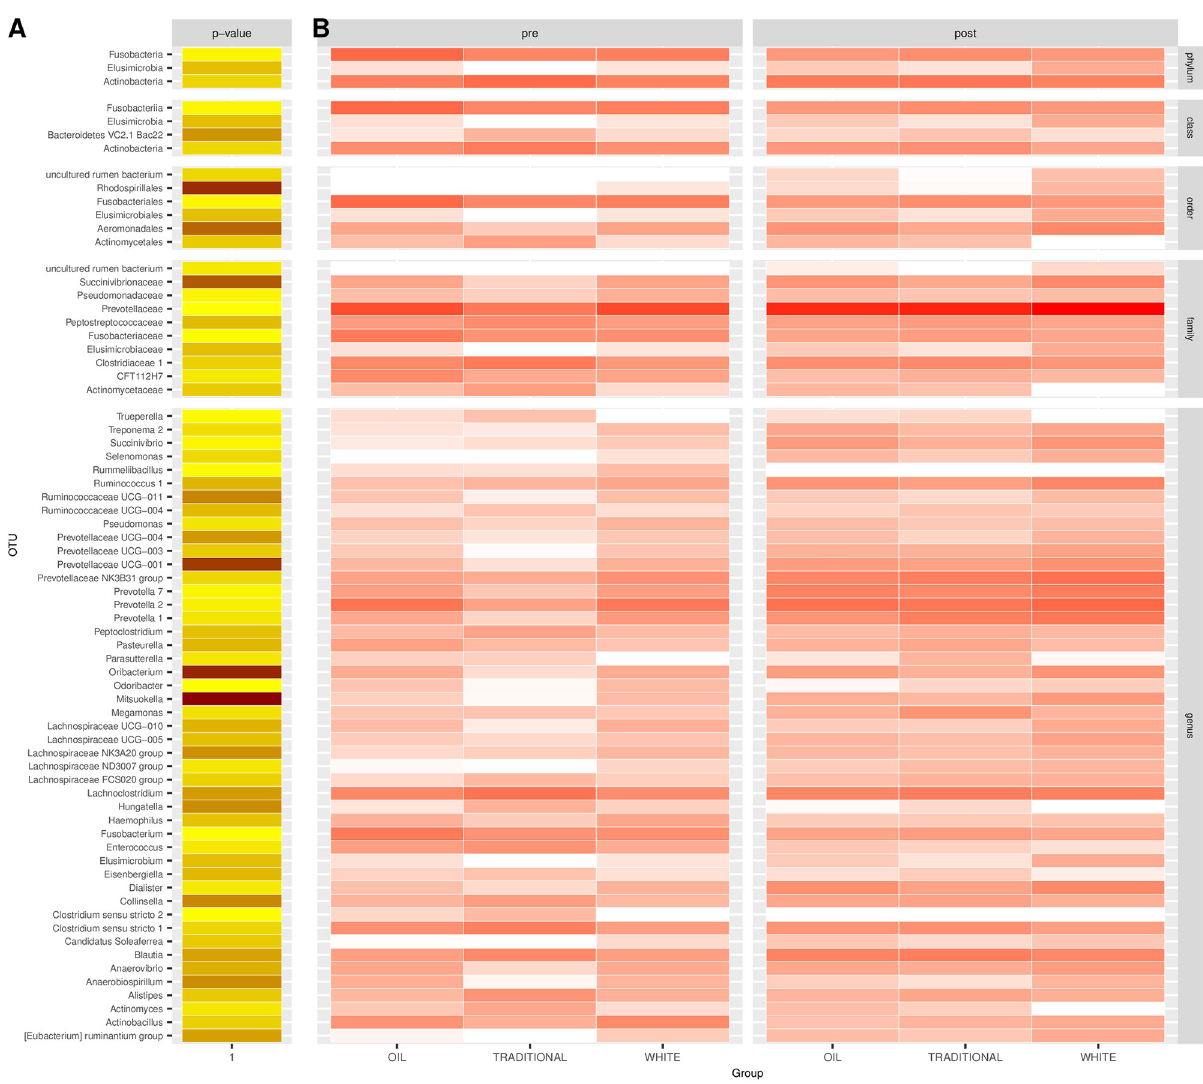
Fig 3. Significantly different OTUs. OTU significantly different between treatments from analysis of variance based on normalised counts: p-values (A) and pre- and post-weaning per-group counts (B). p-value < 0.05 was used as cut-off. Darker colors indicate lower p-values (A) or higher counts (B). Full results are reported in S4 Table.